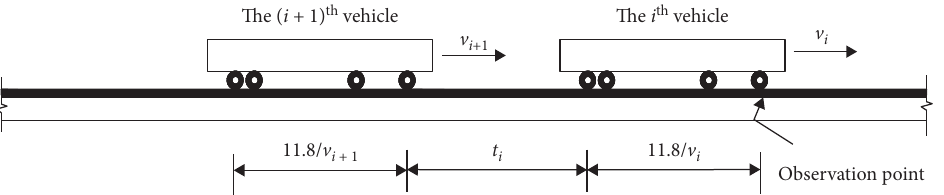
Figure 7: Simulation diagram of random vehicle loads.